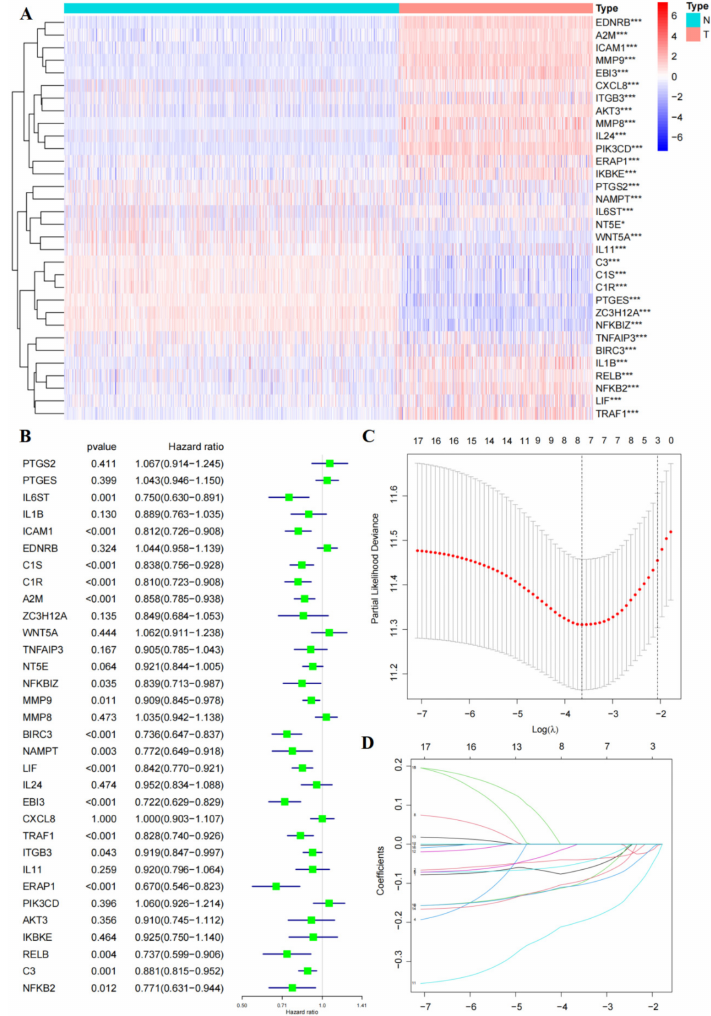
Figure 5. The expression pattern of RBM38-related immune genes in the training cohort and con- struction of prognostic risk signature. ( A ) The expression pattern of RBM38-related immune genes in the training cohort (* p < 0.05, *** p < 0.001). ( B ) RBM38-related immune genes were assessed